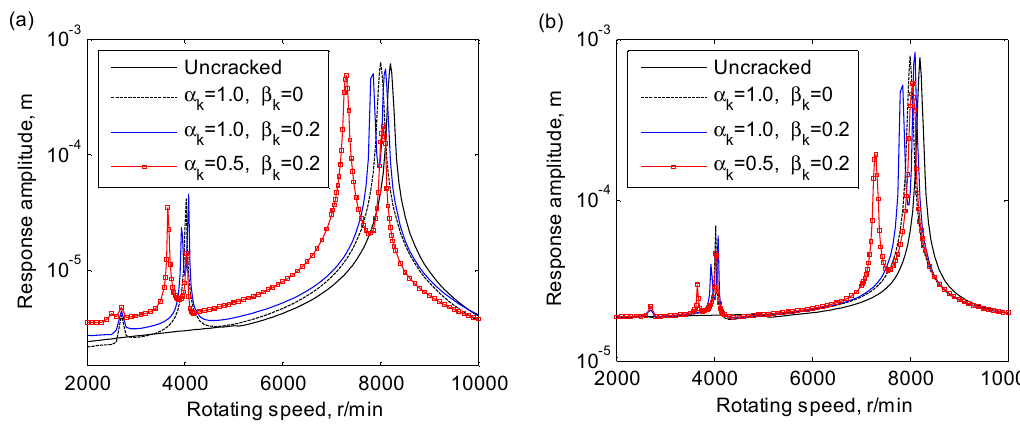
Figure 6. The response amplitudes of the central node of the anisotropic rotor-bearings system with a 20-mm crack versus the rotating speed: ( a ) along the horizontal direction; ( b ) along the vertical direction.